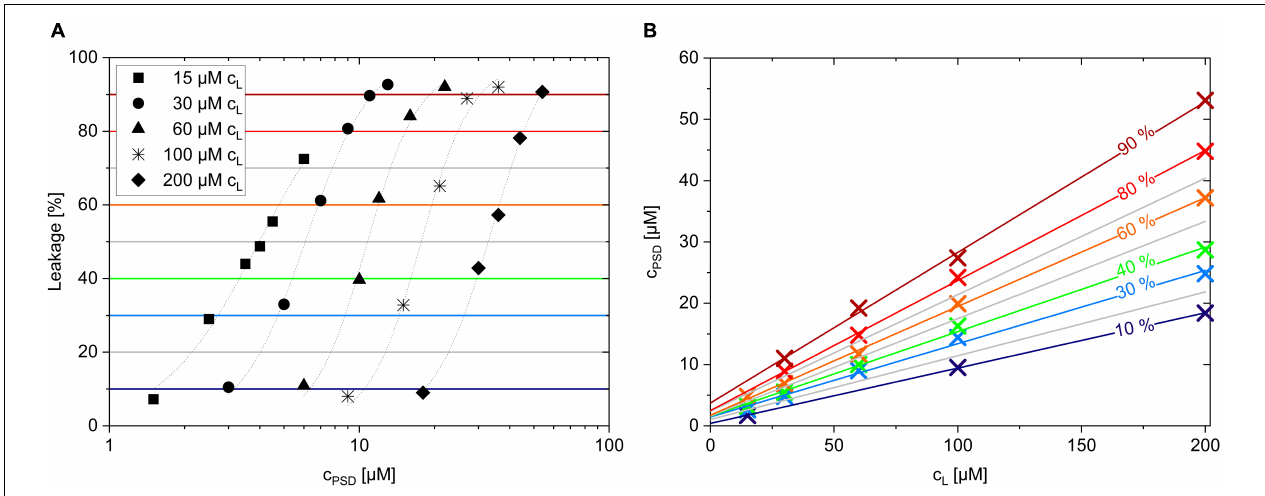
FIGURE 5 | Leakage after 1 h incubation of PSD-C8 with calcein-LUVs with lipid concentrations c L ranging from 15 to 200 µ M (A) . Plotting c PSD needed to trigger a certain calcein leakage (%) for a given lipid concentration, c L , creates the equi-activity plot of PSD-C8 (B)